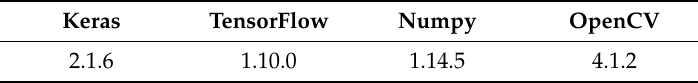
Table 1. The software environment of our